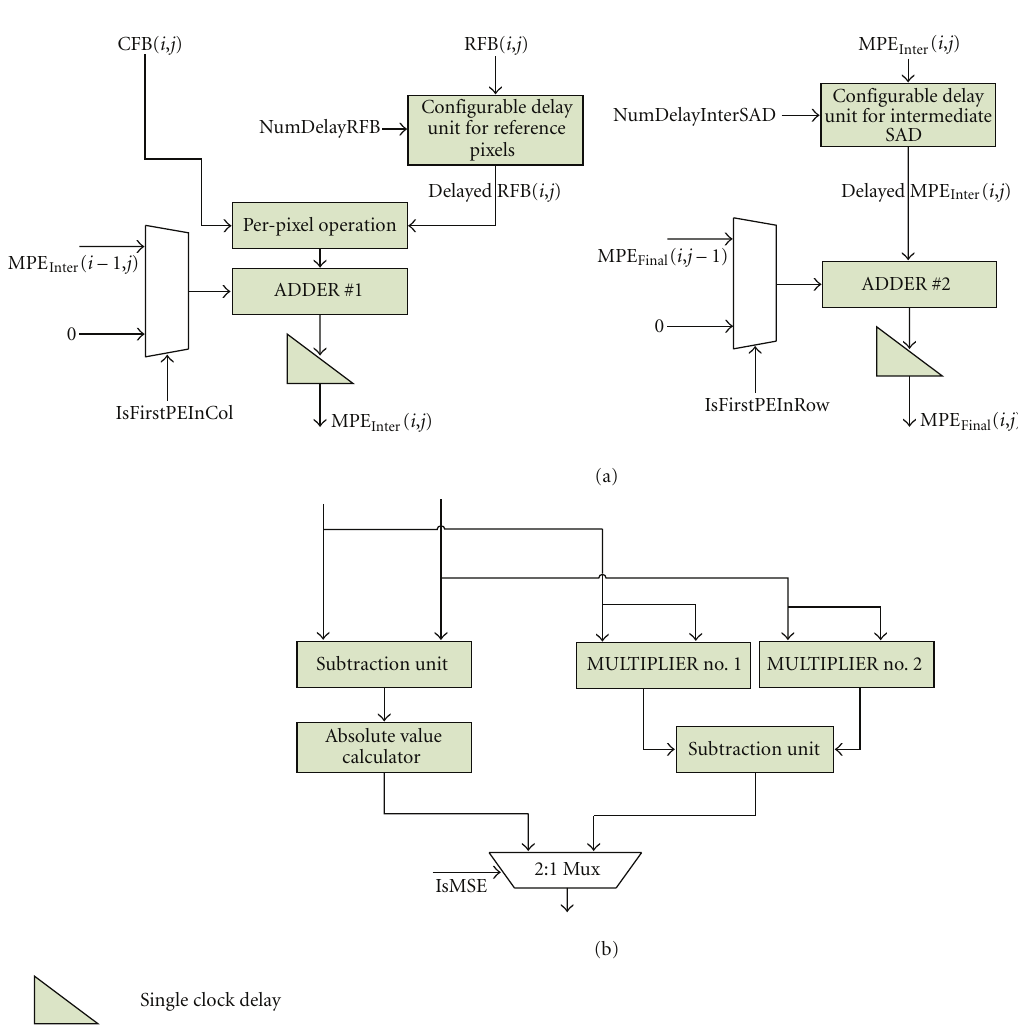
Figure 12: (a) Proposed MPE architecture. MPE Inter ( i , j ) and MPE Final ( i , j ) are two results generated. MPE Inter ( i , j ) is also reused inside the current MPE. (b) Per-pixel operation